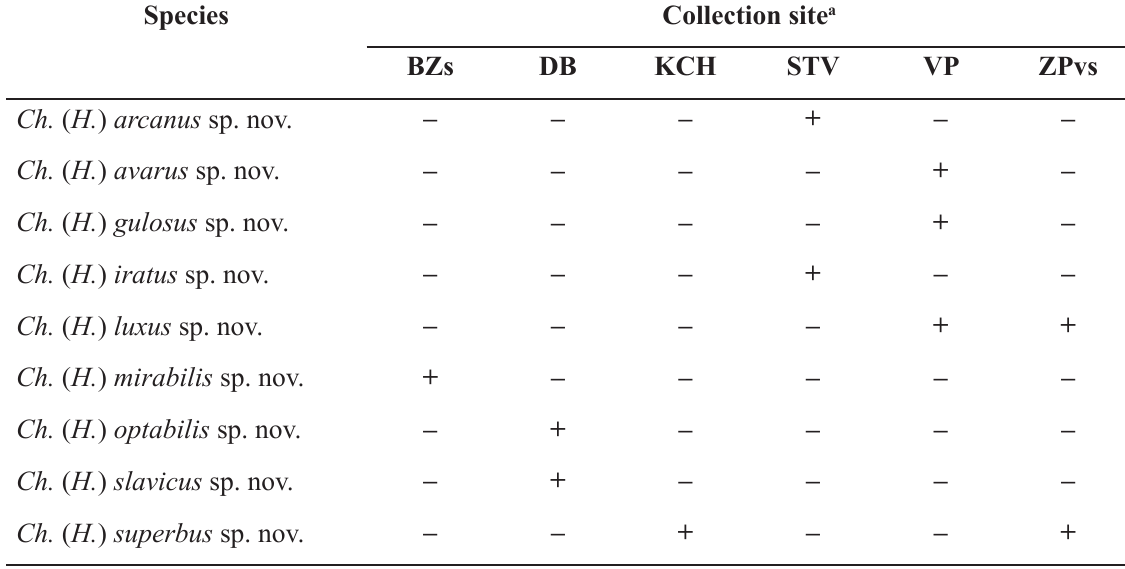
Table 1. Occurrence of nine new species of the subgenus Hystricochaetonotus Schwank, 1990 at six collection sites. a For abbreviations of collection sites, see Material and methods. Plus sign (+) means presence, minus sign ( ‒ )